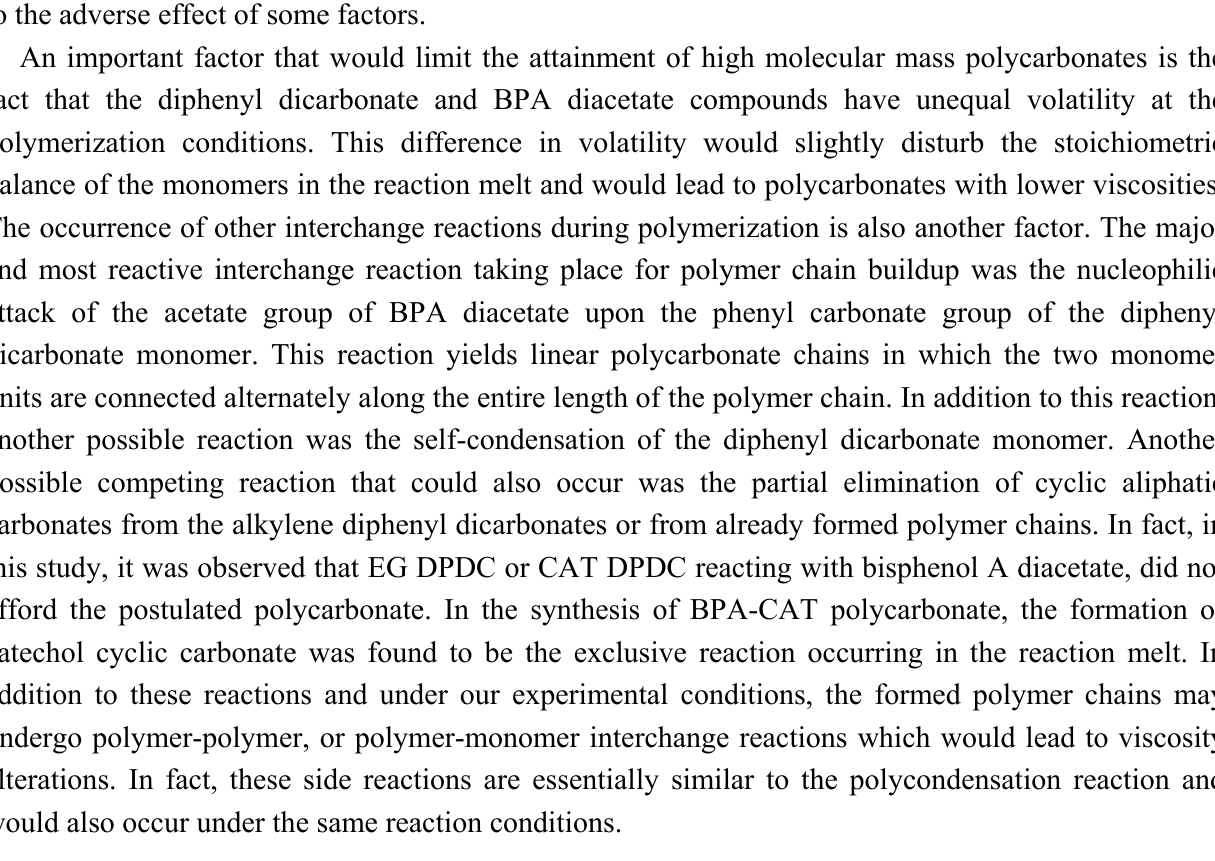
Table 3. Physical properties of polycarbonates as a function of the structure of the